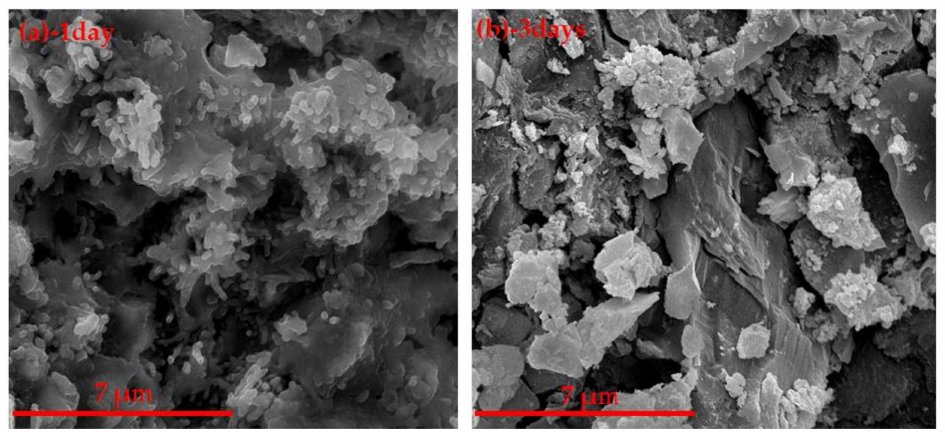
Figure 19. SEM of CF3 hydration paste, ( a ) 1 day, ( b ) 3